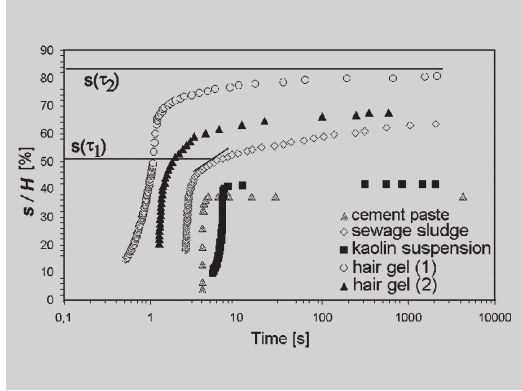
Figure 3: Slump as a function of time as observed with a high speed video camera for different materials. For the hair gel, experiments with two different initial heights have been carried out: 16.4 cm for gel (1), 8.2 cm for gel